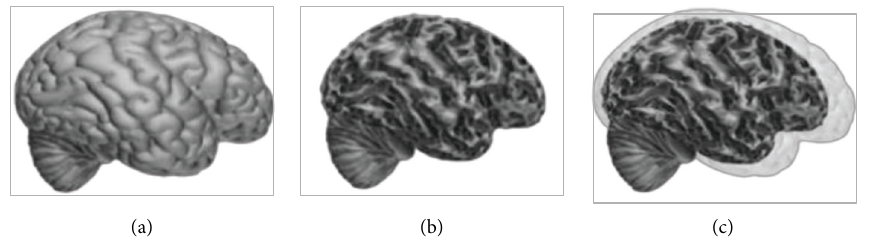
Figure 3: Schematic diagram of normal brain and AD brain and their comparison. (a) Normal brain. (b) Brains of AD patients. (c) Comparison of two.